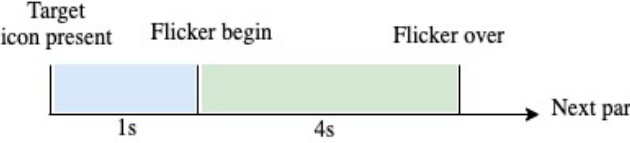
Figure 2. Distribution of the capture time of the SSVEP signal.